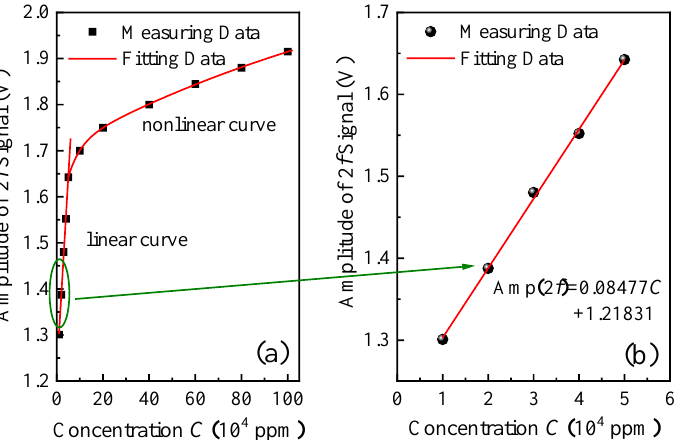
Figure 7. The calibration tests are shown in the whole scope ( a ). The linear part in the low concentration zone, which is pointed by a green line, can be fitted by an equation shown in ( b ).